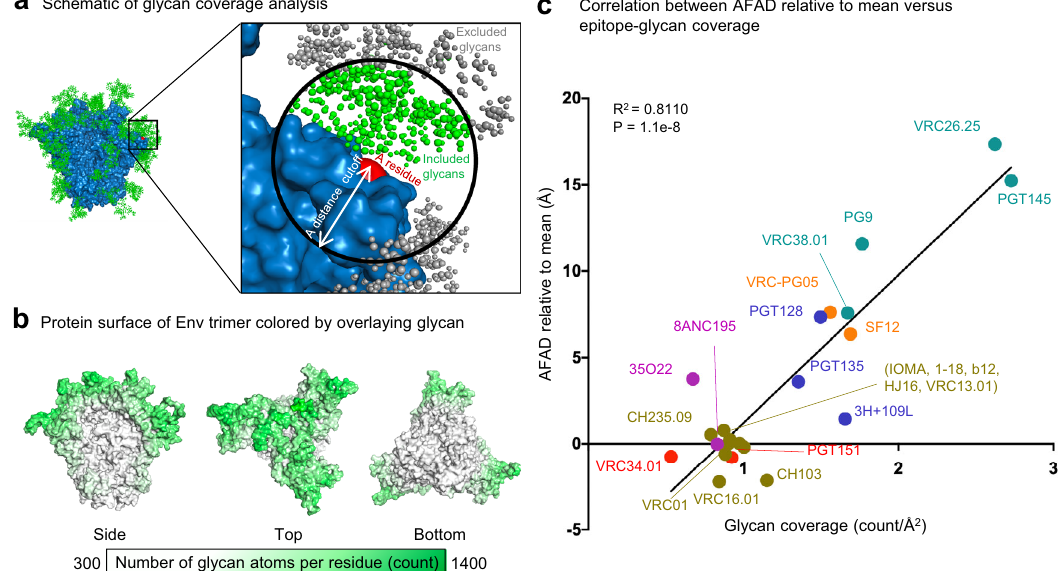
Fig. 3 AFAD correlated signi fi cantly with epitope-glycan coverage. a Schematic fi gure for de fi ning associated glycan atoms per residue. Glycan atoms within a cutoff are counted as number of glycan atoms per residue (green) except those are blocked by protein region (gray). Glycans outside of the cutoff are excluded in the analysis (gray). The protein surface is colored in blue and the residue of interest on the surface is colored in red. b Protein surface of BG505 WT Env trimer colored by number of overlaying glycan atoms. Number of glycan atoms overlaying each exposed protein surface residue was calculated by the algorithm described in ( a ) and averaged over 500 ns molecular dynamics simulations of fully glycosylated HIV-1 BG505 Env trimer. c Correlation of AFAD relative to mean versus glycan coverage overlaying antibody epitopes of BG505 WT. A simple linear regression is calculated with n = 22 antibodies. 2G12 is not presented in the plot due to absence of protein epitope residues. The antibody epitopes are colored as shown in Fig. 2 top right